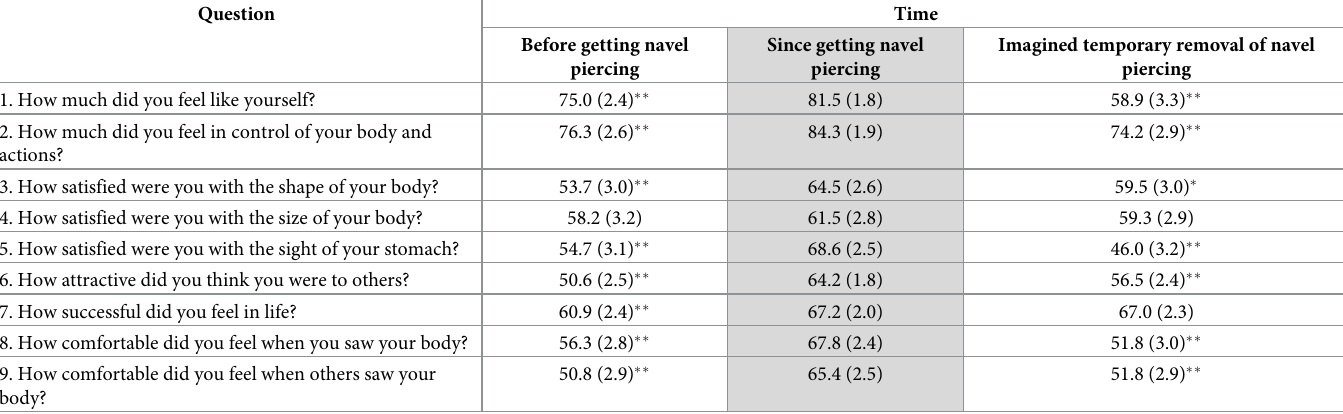
Table 2. Mean VAS ratings (SEMs) for each of the nine body image and self perception questions across the three conditions of time. Single asterisks ( � ) indicate sig- nificant differences (t(101) � 2.83; p � .006, dz � 1.74, 1- β = 1.0) from body perception since getting pierced (grey column) in Bonferroni-corrected pairwise comparisons of estimated marginal means; double asterisks ( �� ) indicate p �